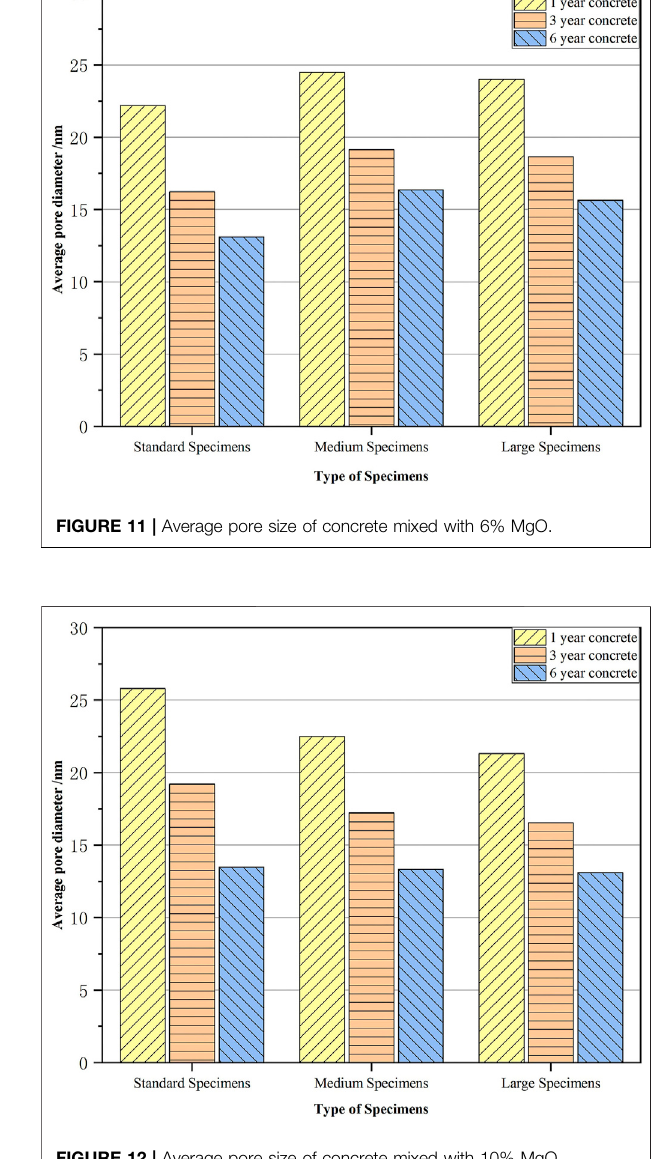
FIGURE 10 | Harmless hole with the diameter smaller than 20 nm in the concrete mixed with 10% MgO.